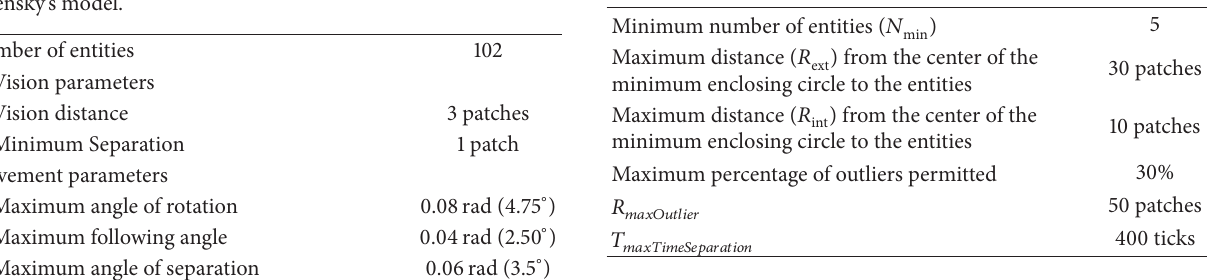
Table 6: Parameters for doughnut formation detection in